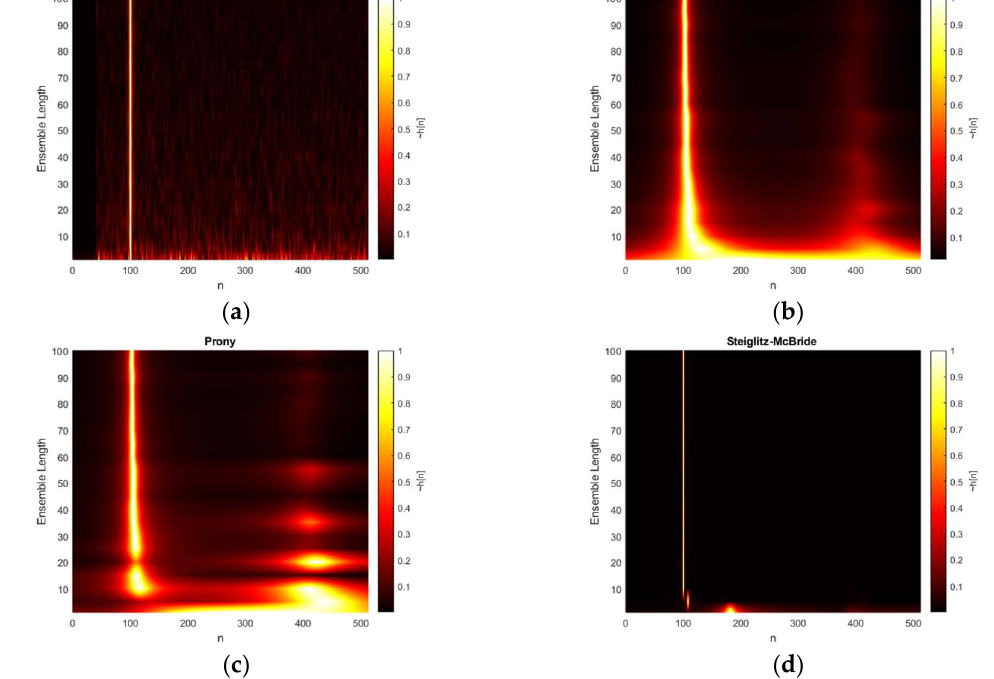
Figure 9. Estimated (cid:101) h [ n ] distribution (normalized) with given ensemble average length & 0 dB SNR from: ( a ) non-parametric HD top-view (interpolated); ( b ) Yule-walker HD top-view (interpolated); ( c ) Prony HD top-view (interpolated); ( d ) Steiglitz-McBride HD top-view (interpolated).